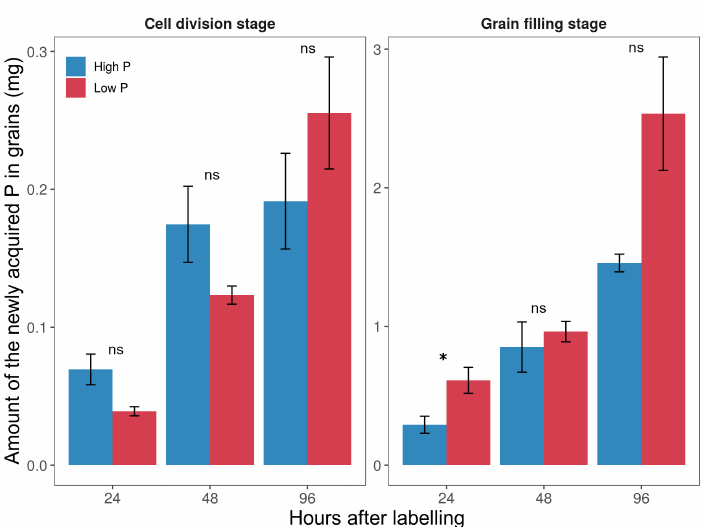
Figure 4. The amount of newly acquired P allocated to grains after the two labeling experiments in high and low P durum wheat plants; 24 h, 48 h, and 96 h represent hours after 32 P labeling. Values are the mean ± standard error of three replicates. The asterisk indicates statistical significance between P supply ( p < 0.05). ns: not significant. Note that the y-scale in the figure is different between the two stages for better